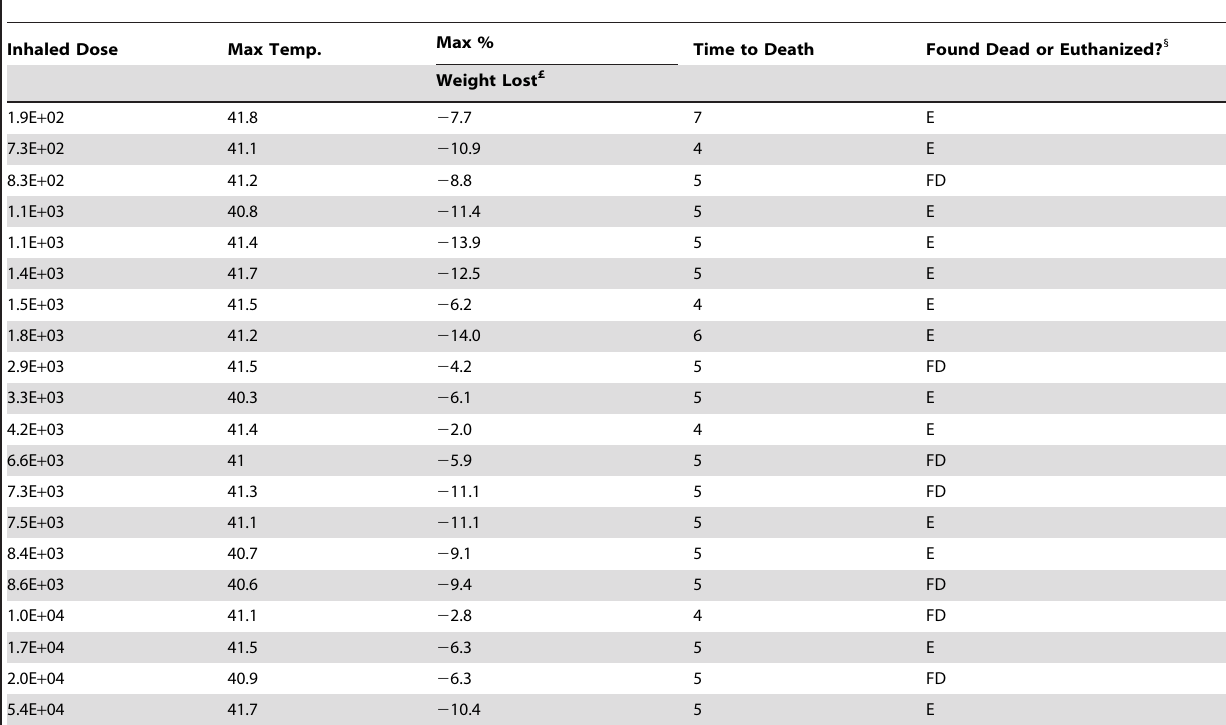
Table 1. Relationship between inhaled dose and disease in rabbits infected with aerosolized F. tularensis.